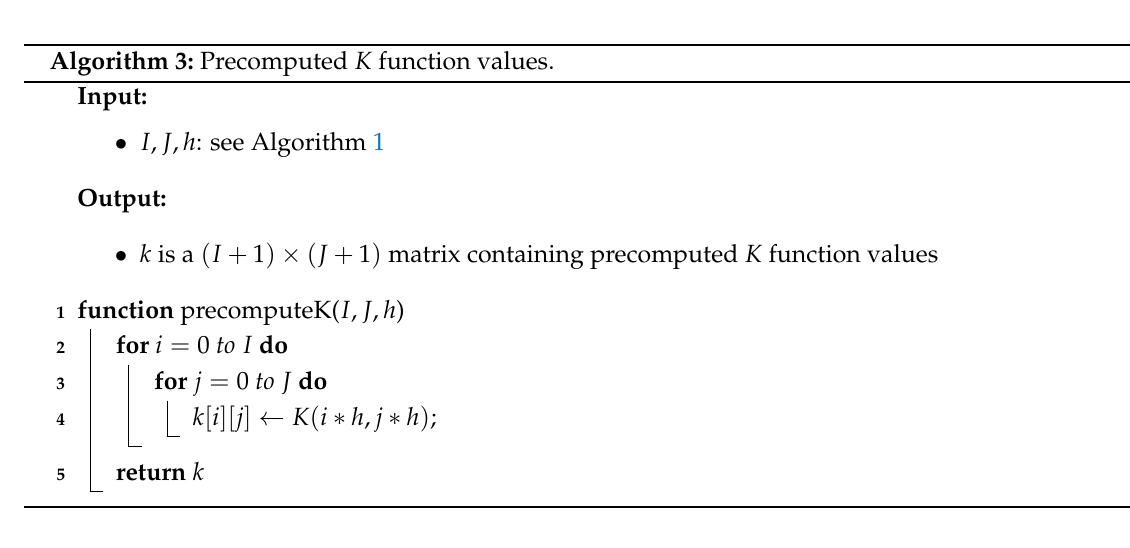
Algorithm 4: Nonlocal diffusion sequential algorithm using precomputed K